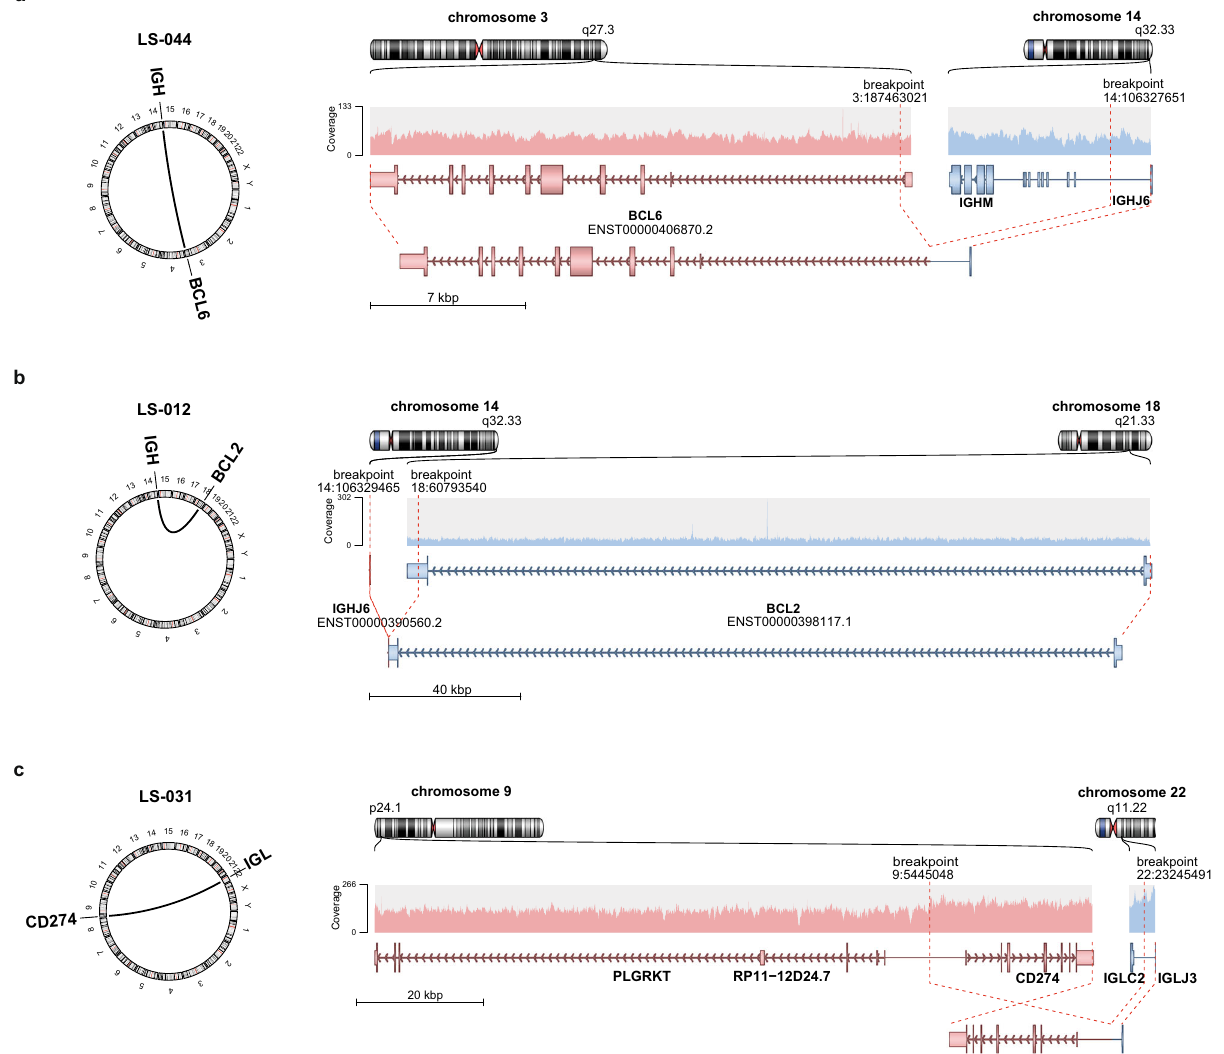
Fig. 5 Immunoglobulin translocations in PCNSL. Schematic representation of the translocation breakpoints involving BCL6 (PCNSL patient LS-044; a ), BCL2 (SCNSL-M patient LS-012; b ), and CD274 (PD-L1; PCNSL patient LS-031; c ). The left panels show a circular plot displaying the location of the translocation partners. The right panel shows the original and reconstructed translocation events. Shown are (from top to bottom) chromosome ideograms, read overage of the sites, the gene models, and the reconstructed translocation